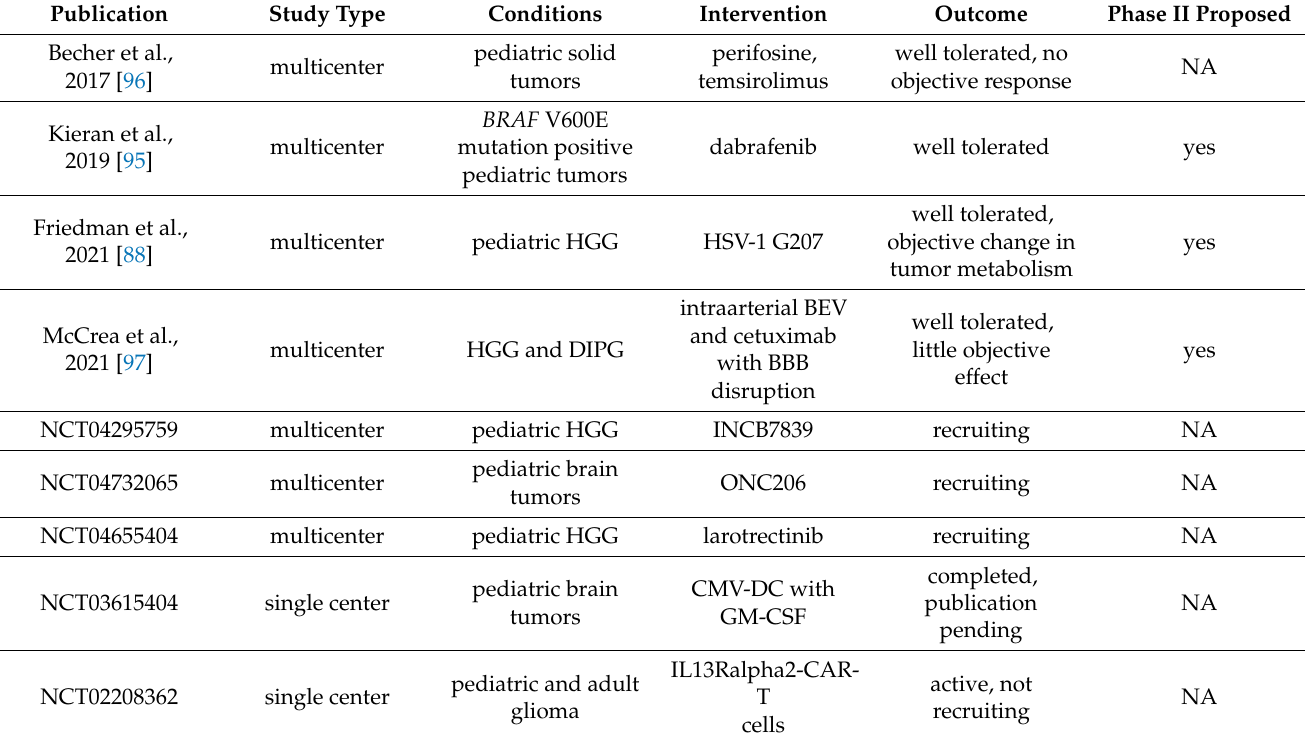
Table 3. Currently recruiting trials and published phase I studies on new pharmacological treatment